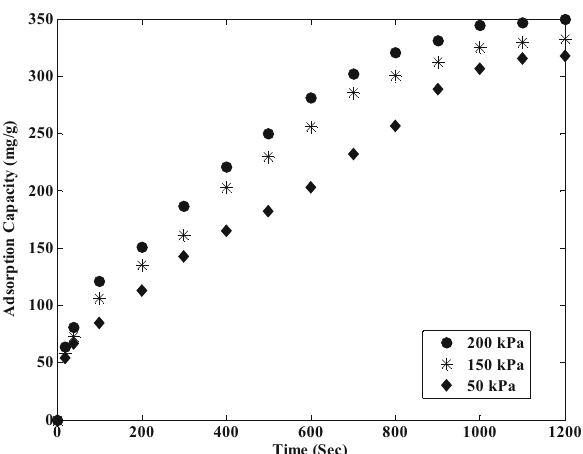
Fig. 6 Effect of gas flow rates on the amount of CO 2 adsorbed